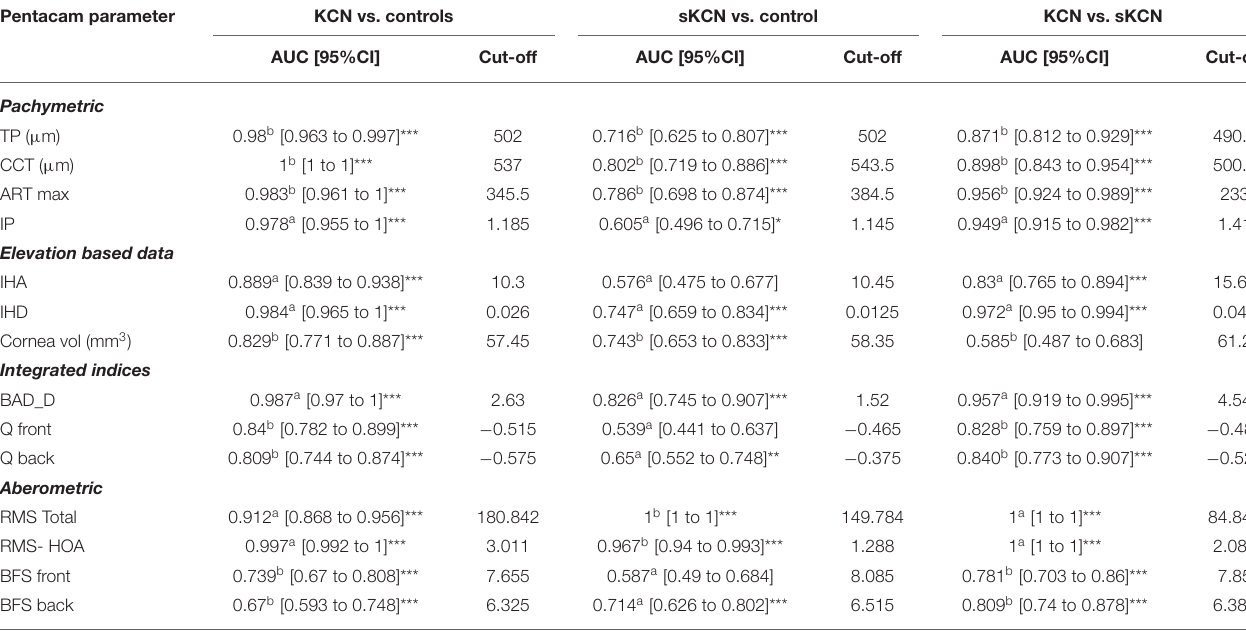
TABLE 6 | Summary of the pachymetric, elevation, integrated, and aberometric Pentacam parameters: AUCs and associated cut-off for KCN vs. controls, sKCN vs. controls, KCN vs. sKCN. Pentacam